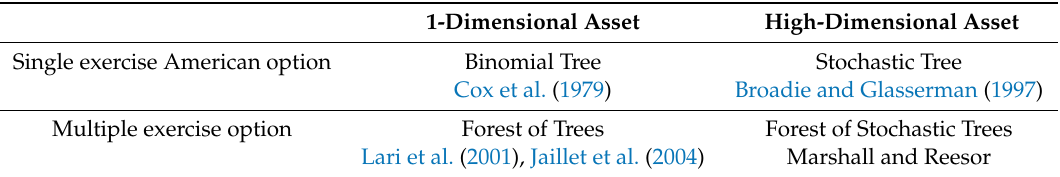
high-dimensional underlying; and (ii) the Stochastic Tree method to multiple exercise options. 1-Dimensional Asset High-Dimensional Asset Single exercise American option Binomial Tree Stochastic Tree Cox et al. (1979) Broadie and Glasserman (1997) Multiple exercise option Forest of Trees Forest of Stochastic Trees Lari et al. (2001), Jaillet et al. (2004) Marshall and